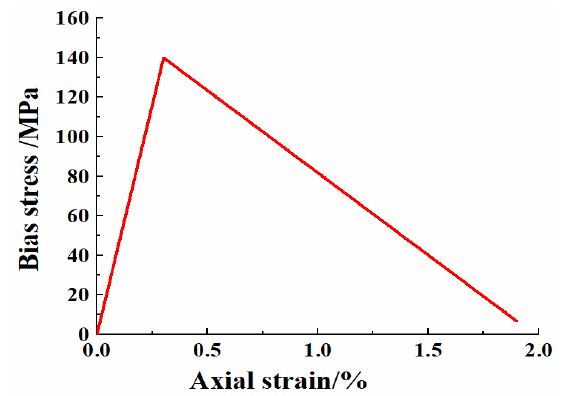
Figure 4. Uniaxial test stress–strain curve of weathered granite.